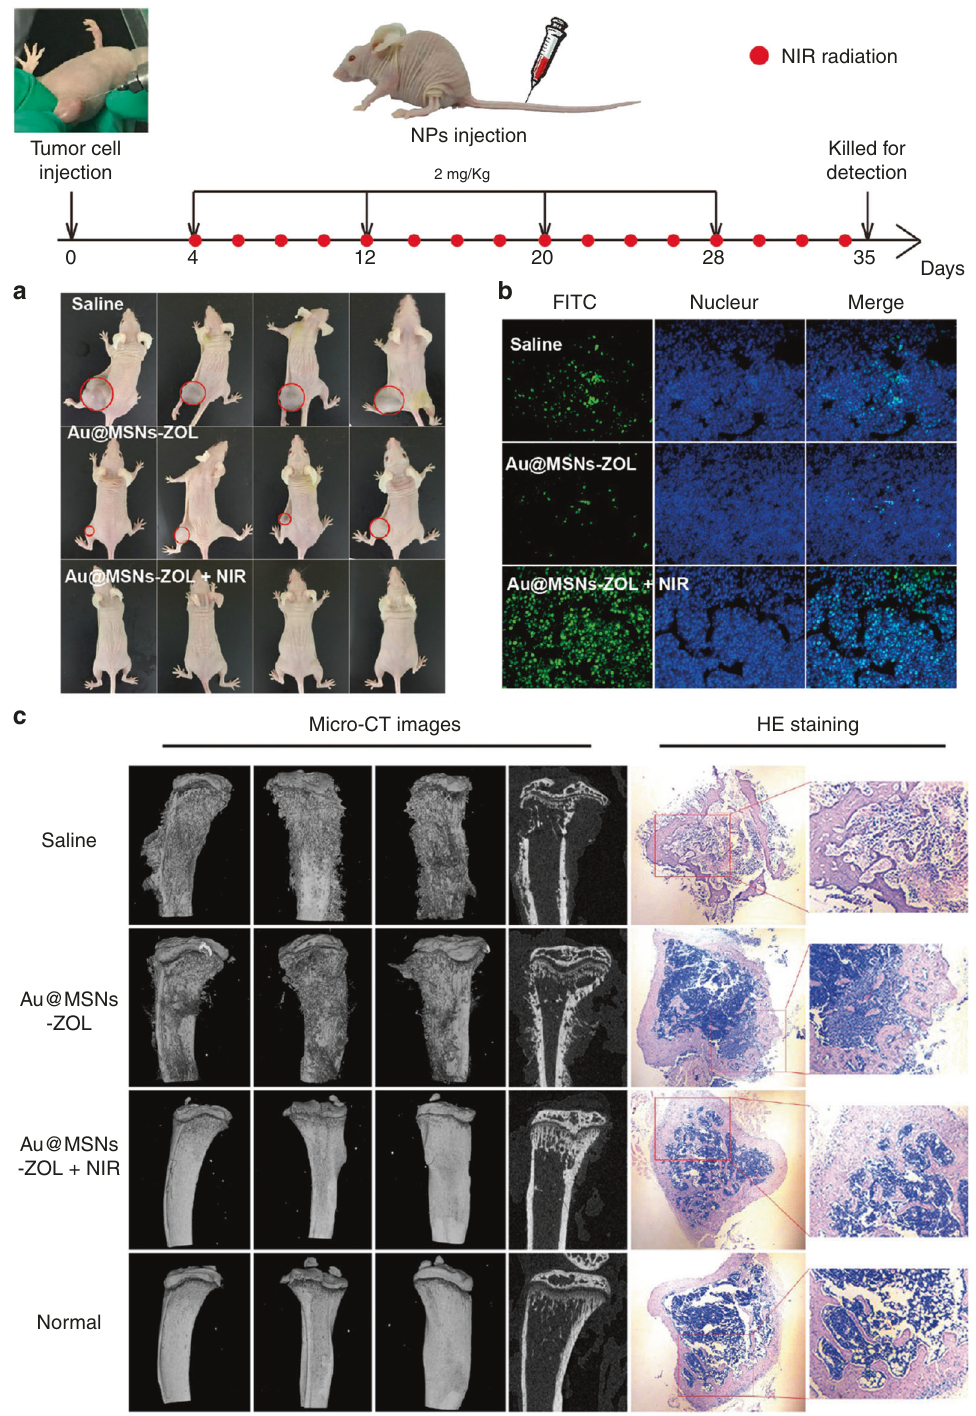
Fig. 5 Bone-targeted nanoplatform combining zoledronate and photothermal therapy to treat breast cancer bone metastasis. Top: Timeline of the treatment schedule. A breast cancer bone metastasis mouse model was established by direct injection of MDA-MB-231 cells into the left hindlimbs of nude mice. Nanoparticles and NIR irradiation were administered as indicated. a Images of tumor-bearing nude mice recorded at the end of treatment (day 35). b TUNEL fl uorescence detected in the tumor slices. c CT images of the tibias from different angles and micrographs of H&E-stained tibias (right). Reprinted with permission from ref. 167 © 2019, ACS With the bene fi ts of locally administered (3D-printed scaffolds,